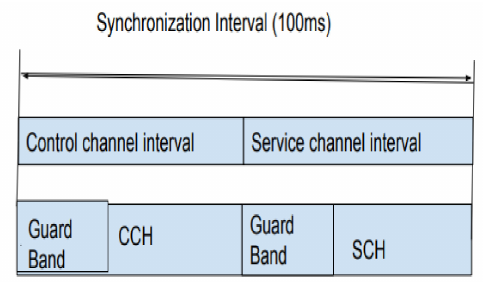
Figure 3. Synchronization interval